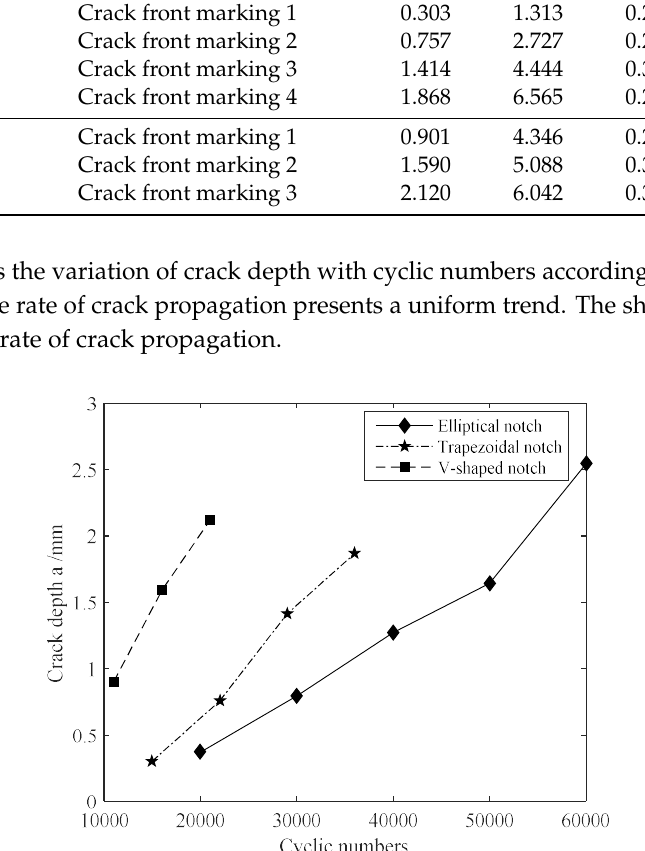
Table 7. Test data of steel wire crack propagation with notches of different shapes.